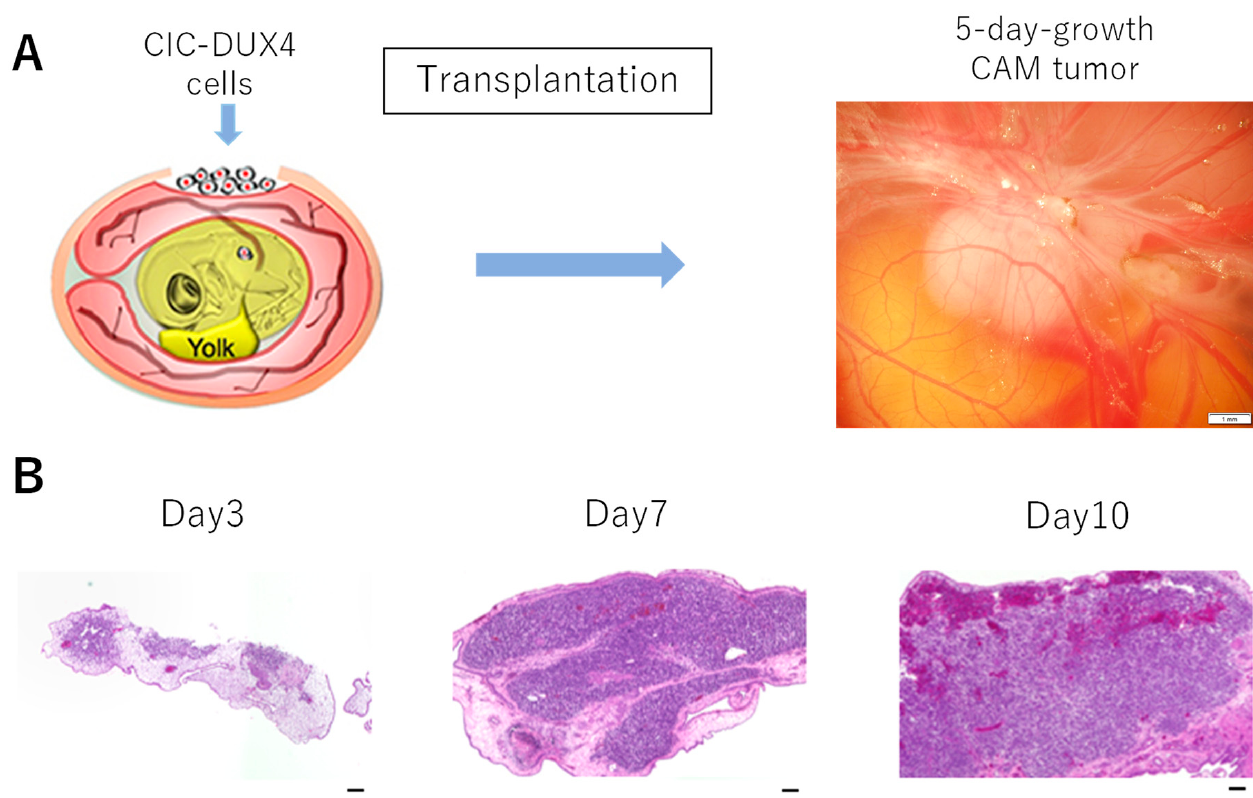
Figure 1. ( A ): After transplanting CD-292 cells on top of the CAM membrane of fertilized eggs, we observed formation of a tumor-like structure seen by white area. Scale bar in the right photo represents 1 mm size. ( B ): The CAM tumor was cut out at different times, and thin sections were made and examined by H&E staining. Scale bar represents 0.1 mm.